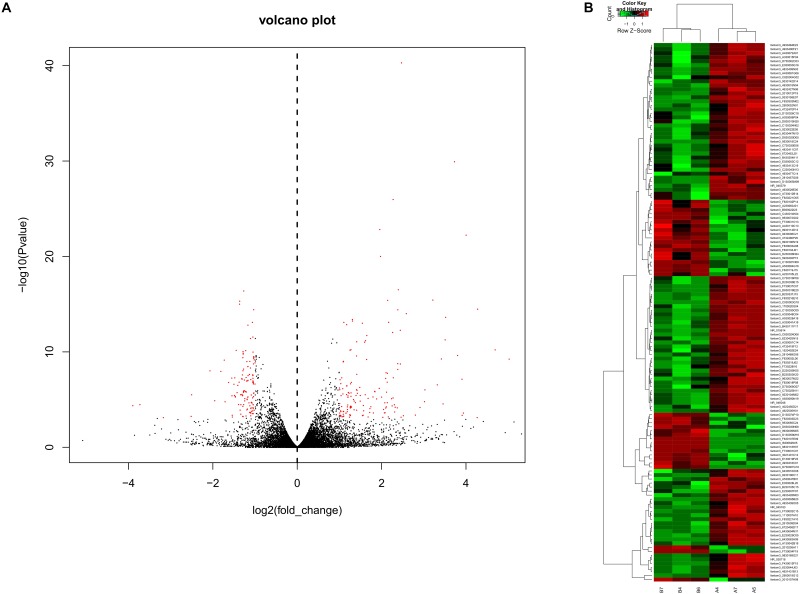
Volcano plots and heat maps of lncRNA expression between the asthma and control groups. (A) Volcano plot assessment of lncRNA expression in CD4+ T cells between the asthma and control groups. Red dots represent different lncRNAs (p < 0.05) showing fold changes >=2 or <= -2. (B) Heat map analysis of differentially expressed lncRNAs between the asthma and control groups. Green indicates low expression, and red indicates high expression. A4, A5, and A7 were the control group; B4, B6, and B7 were CD4+ T cells from the asthma group.